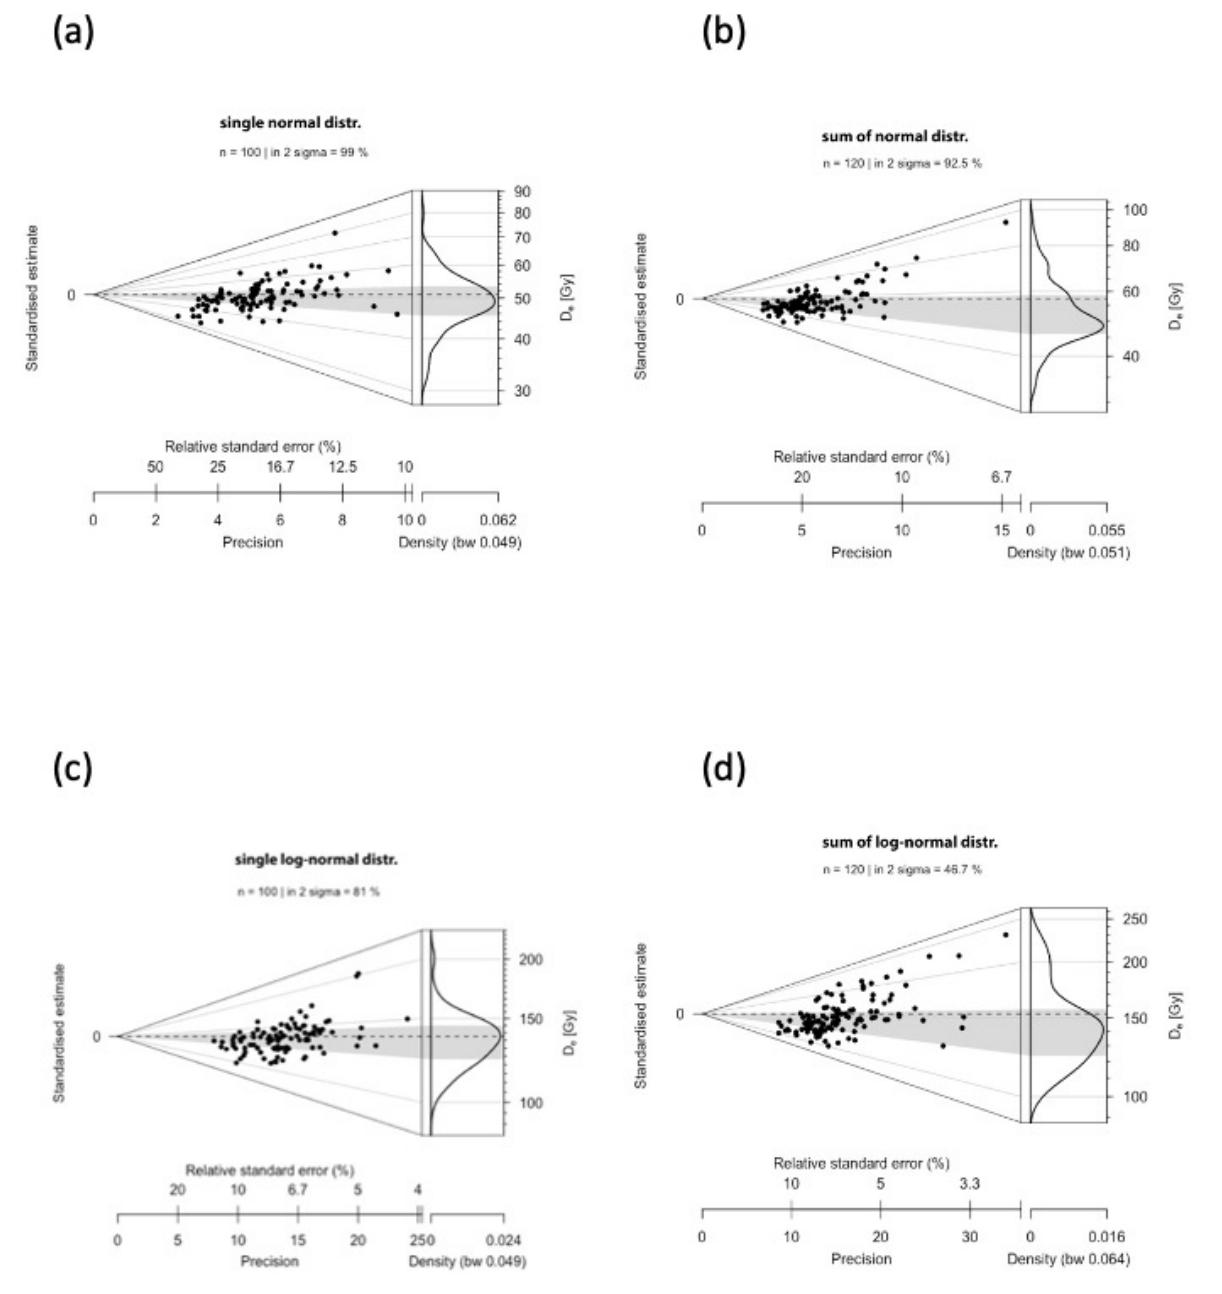
Figure 6. Abanico plots of the D e distributions (100 values) without outliers. (a) Single normal distribution, (b) sum of two normal distri- butions, (c) single log-normal distribution, and (d) sum of two log-normal